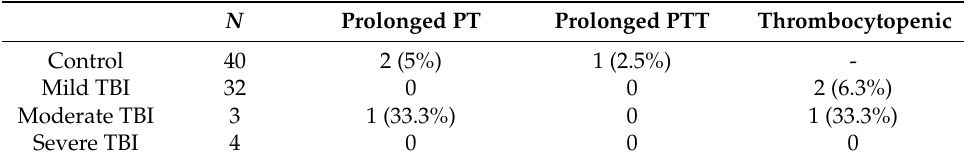
Table 4. Coagulopathy by PT, PTT, and platelet count in isolated TBI patients with CT abnormalities. N Prolonged PT Prolonged PTT Thrombocytopenic Control 40 2 (5%) 1 (2.5%) - Mild TBI 32 0 0 2 (6.3%) Moderate TBI 3 1 (33.3%) 0 1 (33.3%) Severe TBI 4 0 0